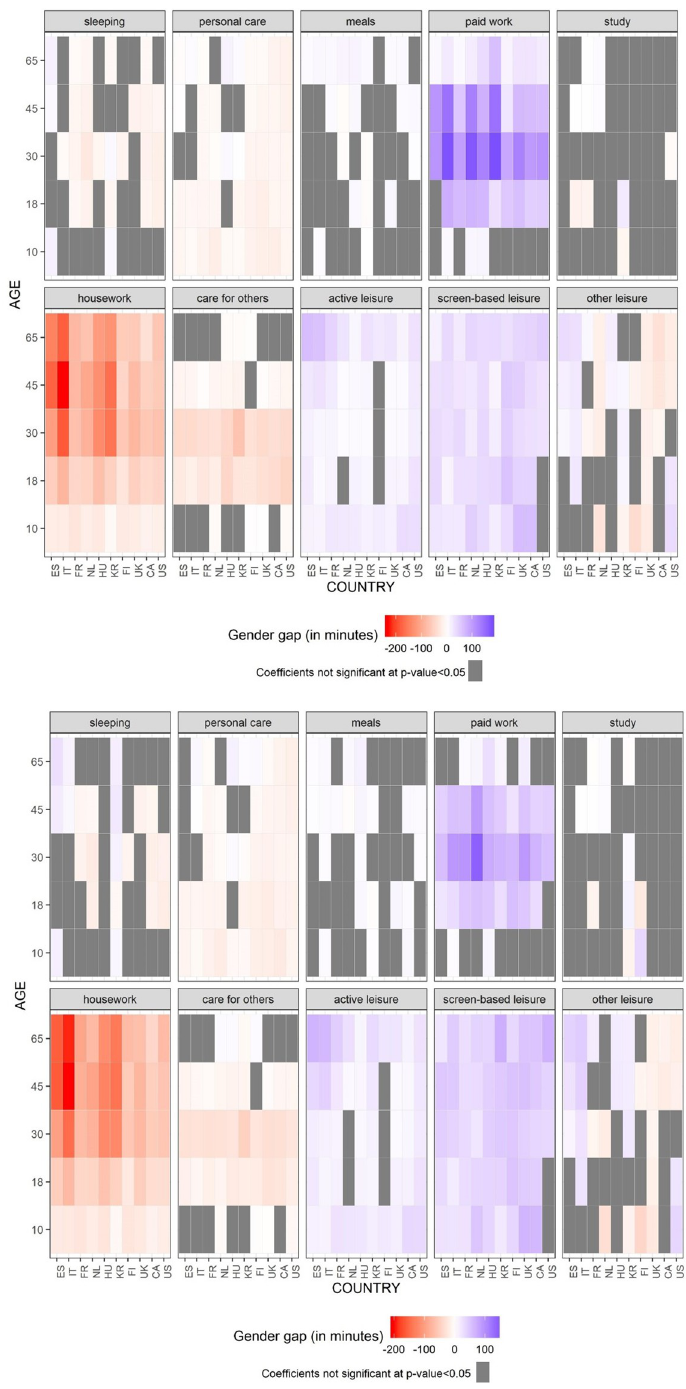
Fig 4. Gender differences in time use. Panel A. Without adjusting for socioeconomic and demographic factors. Panel B. Adjusting for socioeconomic and demographic factors. Source: Own calculations from the Multinational Time Use Study [32]. Notes: Estimates for Panel A are available in Table A3 in S1 Appendix and for Panel b in Table A4 in S1 Appendix. Estimates correspond to the coefficient for Category Men (ref = Women) from the OLS regressions by country and group of age. Panel A also control by day of the week. Panel B also control by day of the week, educational attainment, employment status, children in the household and union status.